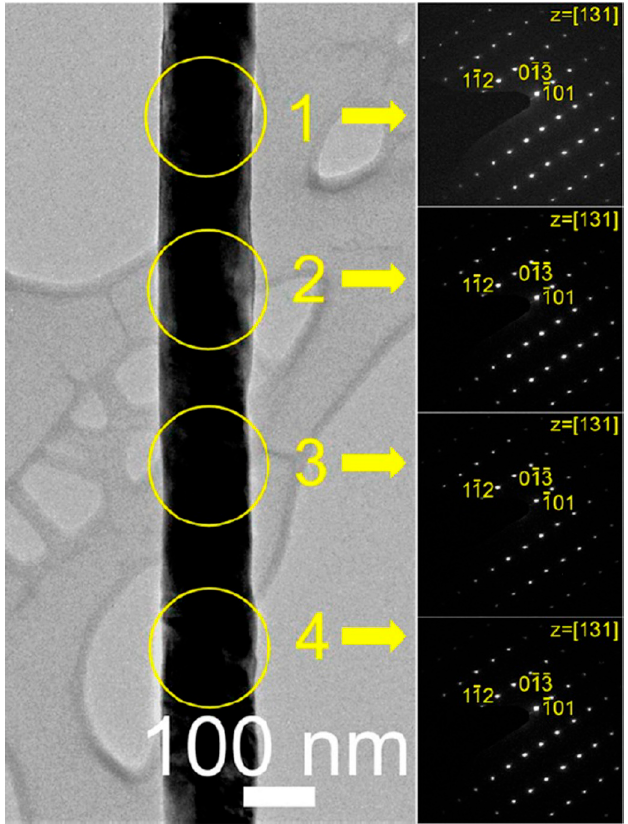
Figure 9. TEM image and selected area electron diffraction (SAED) patterns for the Mn 3 O 4 NW. Reprinted from [84] with permission. Copyright (2012) American Chemical Society.